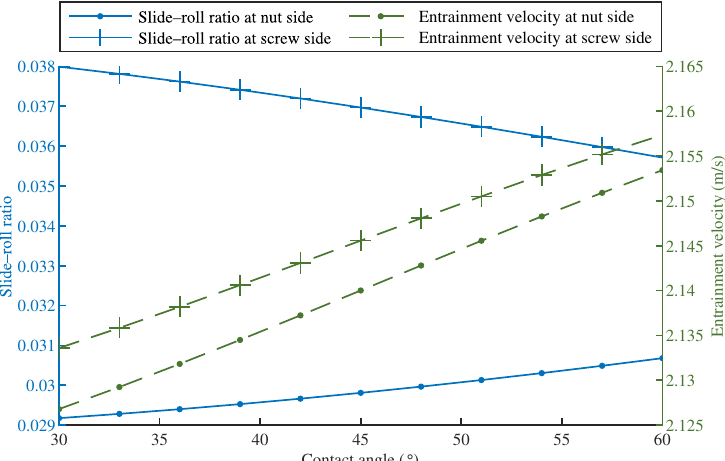
Figure 6. Slide–roll ratio and entrainment velocity under various contact angles.